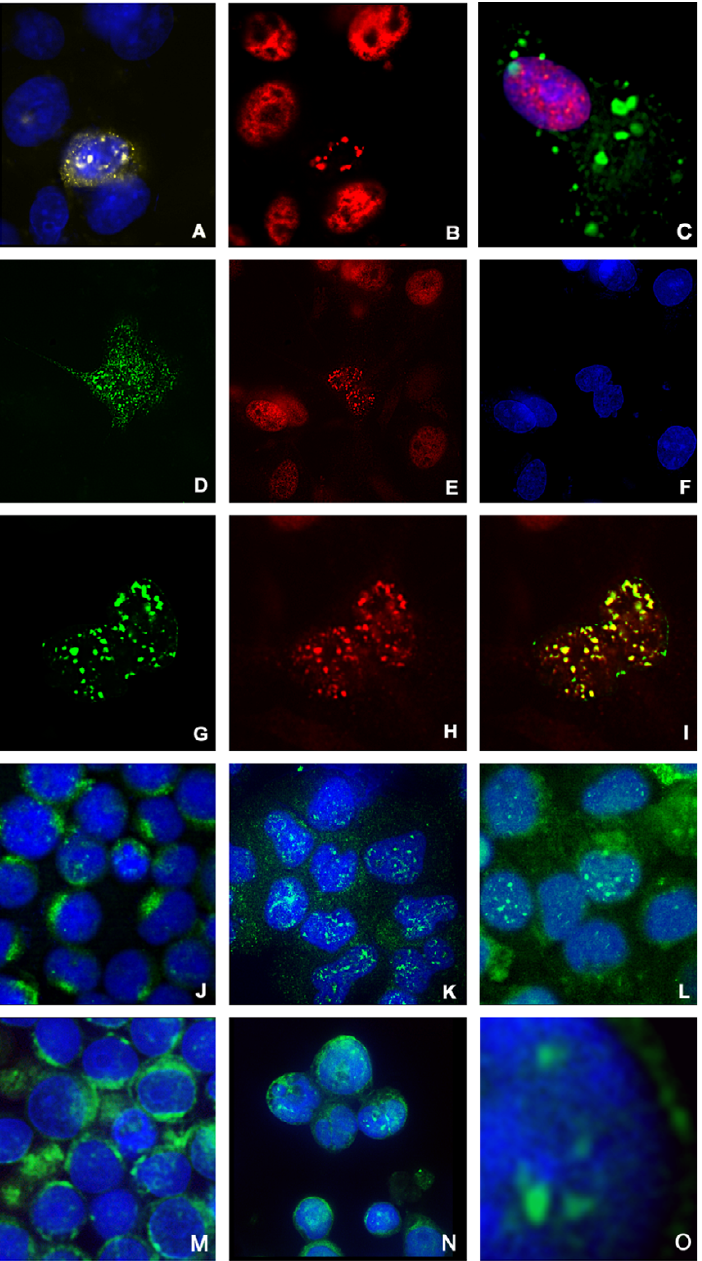
Figure 6 Expression of EBNA-3 (B, E, H – red) from recombinant vaccinia virus in cells that were transfected with GFP-F538 (A, D, G – green) leads to the accumulation of GFP-F538 in the nucleus in parallel with the redistribution of EBNA-3 from homogeneous nucleoplasmic pattern to well circumscribed nuclear granules. In these granules EBNA-3 (H) shows high levels of co-localiza- tion (I) with GFP-F538 (G). Expression of EBNA-5 (C – red) from recombinant vaccinia virus does not change the cytoplasmic localization of GFP-F538 (C – green). Immunofluorescence staining of endogeneous F538 protein with rabbit polyclonal anti- bodies shows cytoplasmic distribution in the EBV negative BL cells DG75 (J) but gives predominantly nuclear staining in EBV positive BL cells Raji (K) or EBV transformed lymphoblastoid cell line 940110 (L). DG75 cells that express EBNA-5 show the same cytoplasmic distribution as the parental cells (M) whereas EBNA-3 expressing DG75 cells demonstrate nuclear accumu- lation of the F538 protein (N). High magnification image of the nucleus show that F538 preferentially accumulates in low DNA density areas that corresponds to the euchromatin (O) DNA staining with Hoechst 33258 is